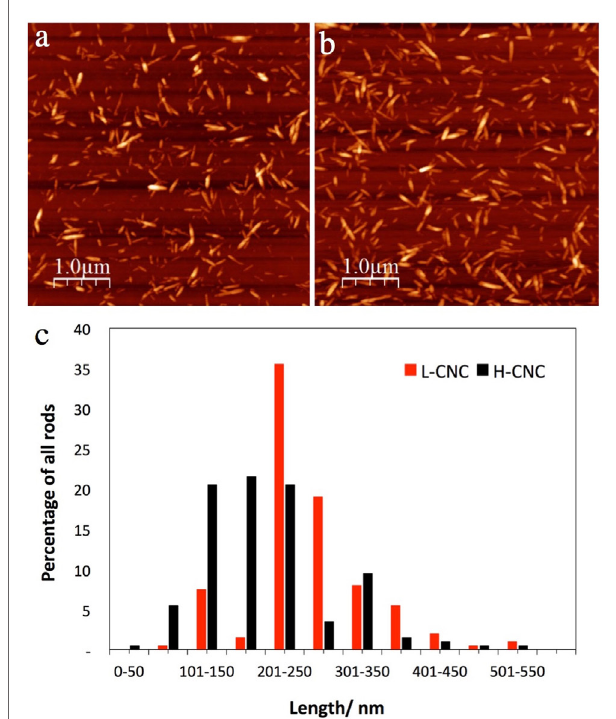
FigUre 2 | representative aFM images of (a) l-cnc and (B) h-cnc, together with an overview (c) of the length distribution of both samples . In both cases, the CNC mass fraction in the starting suspension was w = 3